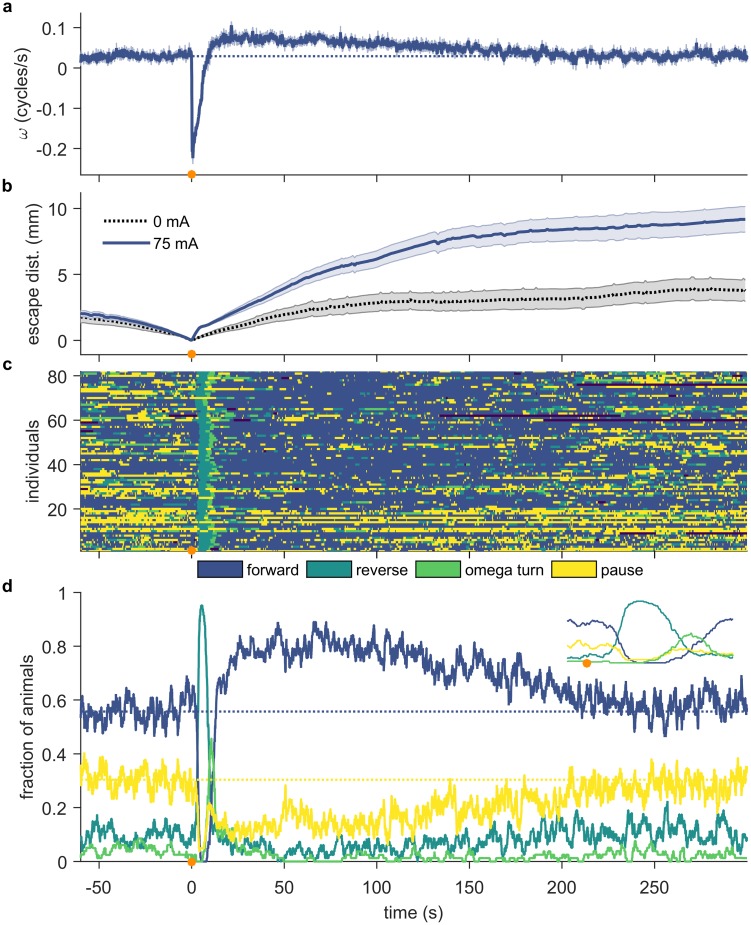
A single thermal stimulus elicits an immediate rapid escape response, and an extended period of locomotory arousal.The thermal stimulus is delivered by an IR laser (100 ms 75 mA pulse) targeted at the animal’s head (anterior 1/5th), and focused by a 75 mm lens. Plots are aligned so that the stimulus is at t = 0 s (indicated by an orange circle). (a) Mean phase velocity of the population of worms. Shaded region indicates the standard error of the mean. Note that the population’s average phase velocity takes greater than 180 s to return to pre-stimulus levels (the dotted dark blue line indicates the average pre-stimulus phase velocity). (b) Mean escape distance: the radial distance between the worm’s instantaneous centroid position and the centroid location at the time of the stimulus. The dotted black line shows data for unstimulated control animals. (c) Ethogram showing the instantaneous behavioral states of individual animals. One of four discrete states is assigned to each animal in each frame: forward, reverse, omega turn, or pause. (d) Fraction of animals in each behavioral state before and after the stimulus. The inset shows the period from 2 s before the stimulus until 15 s after the stimulus. Notice the well-described reverse-turn-forward sequence in the 15 s following the stimulus, indicated by the spike in reversal probability, followed by the spike in turn probability, and finally the elevated forward probability. The dotted dark blue and yellow lines indicate the average pre-stimulus fraction of the population occupying the forward and pause states, respectively. n ≥ 73 individuals.